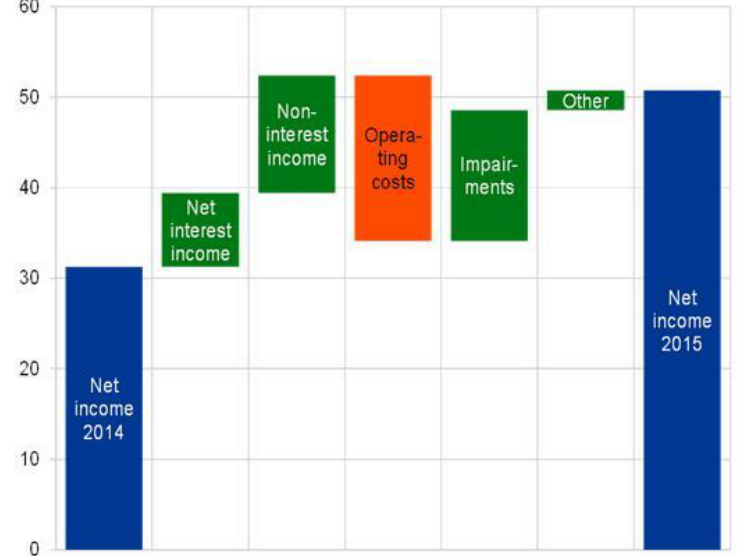
Figure 9. Change in net income of euro area significant banking groups (decomposition of change in net income between 2014 and 2015 in billions of euro). Source: SNL Financial and ECB calculations. Note: Based on data for a sample of 83 euro area significant banking groups.